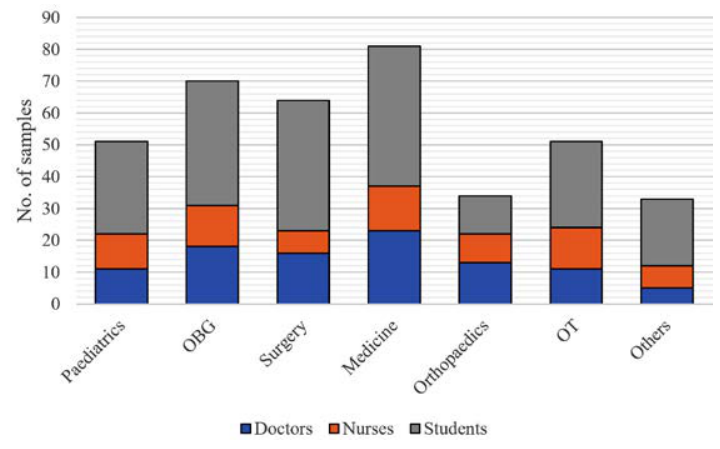
Fig. 1. Distribution of the samples among various departments and health care